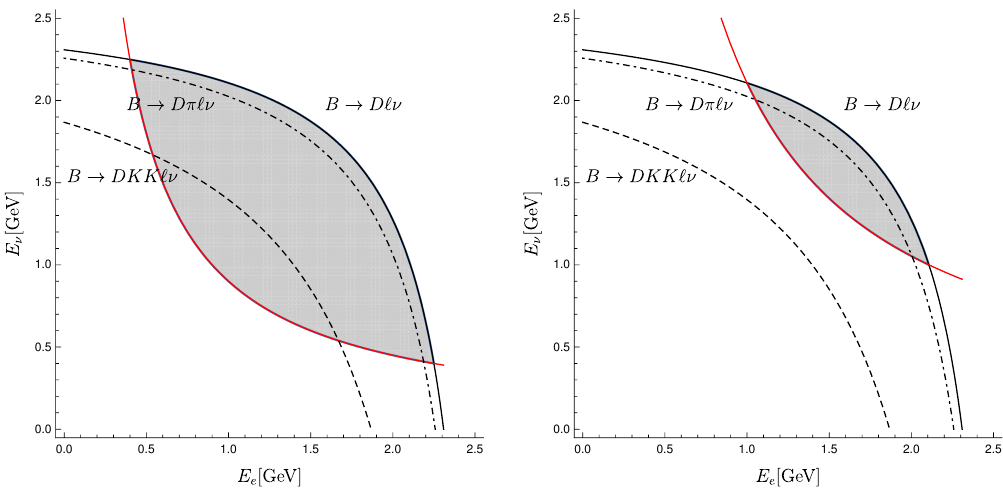
= 3 : 60 GeV 2 (left) and q 2 = 8 : 43 GeV 2 cut cut